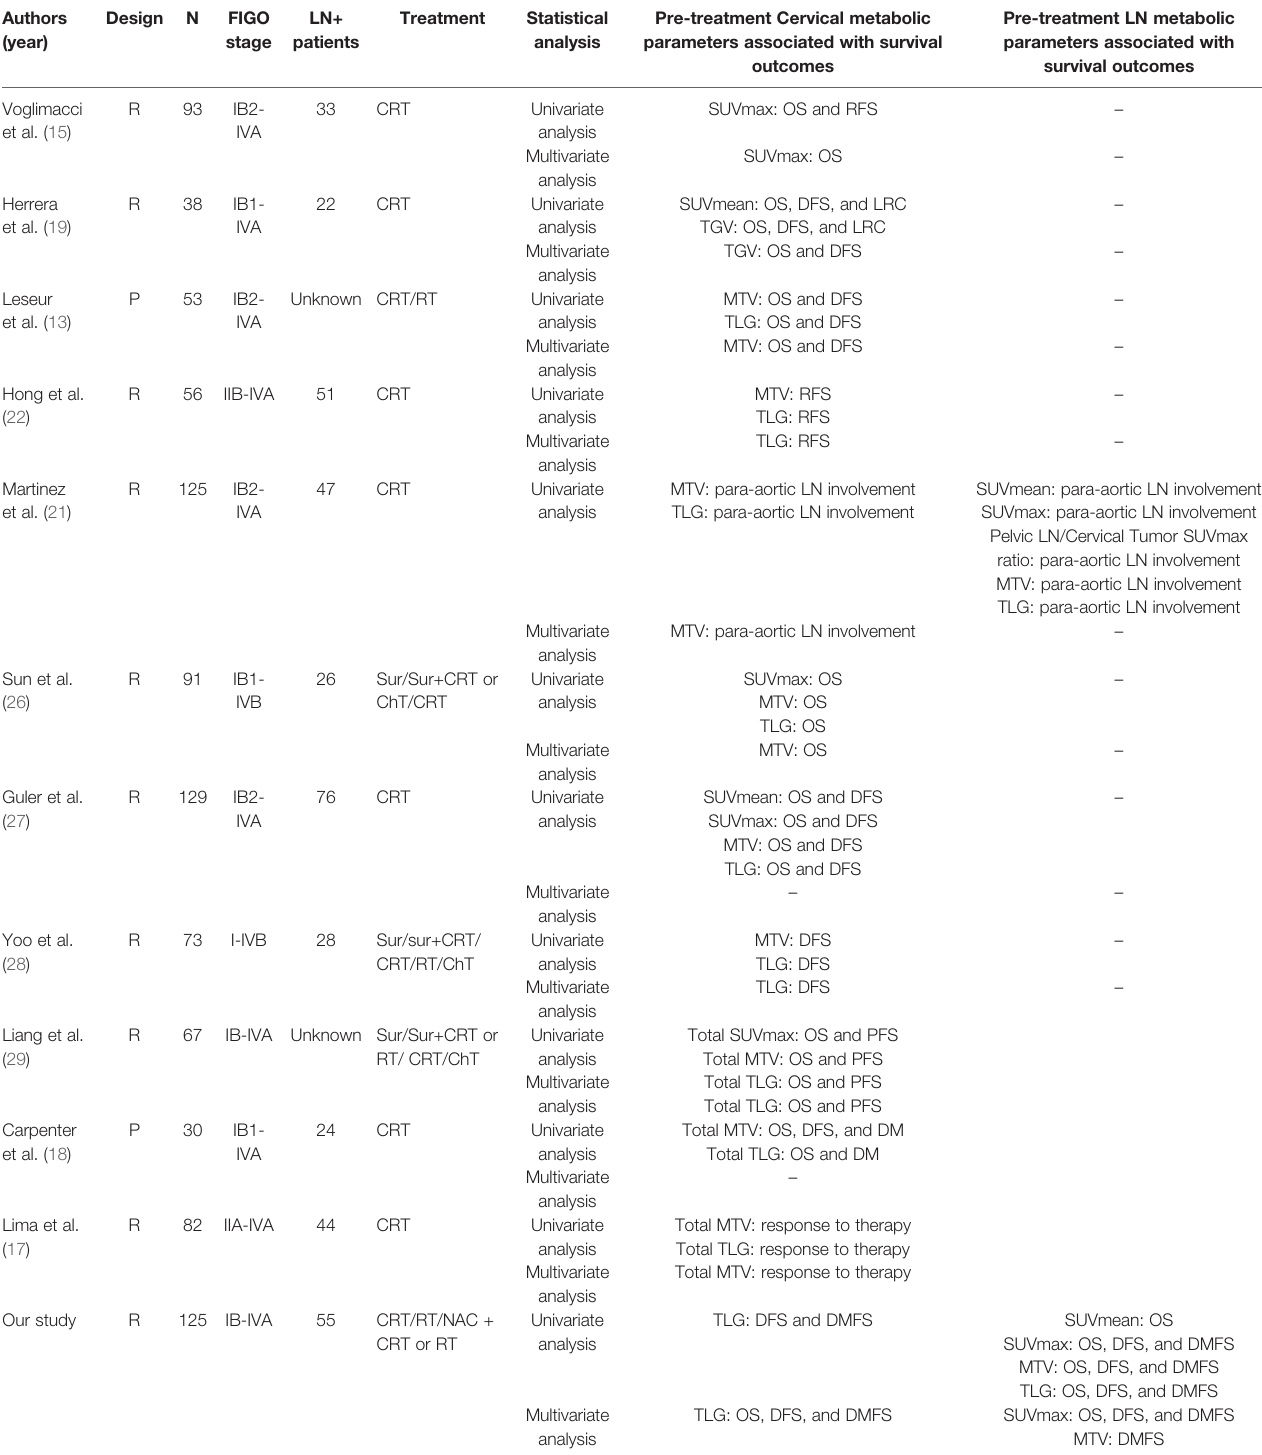
TABLE 5 | Previous studies regarding pre-treatment metabolic parameters in patients with locally advanced cervical cancer. Authors